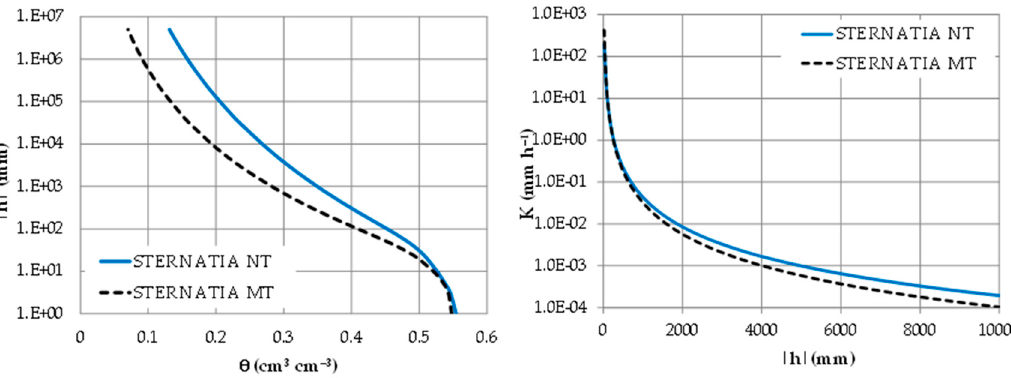
Figure 7. Soil water retention curve and hydraulic conductivity function (left and right, respectively) obtained at the Sternatia site.